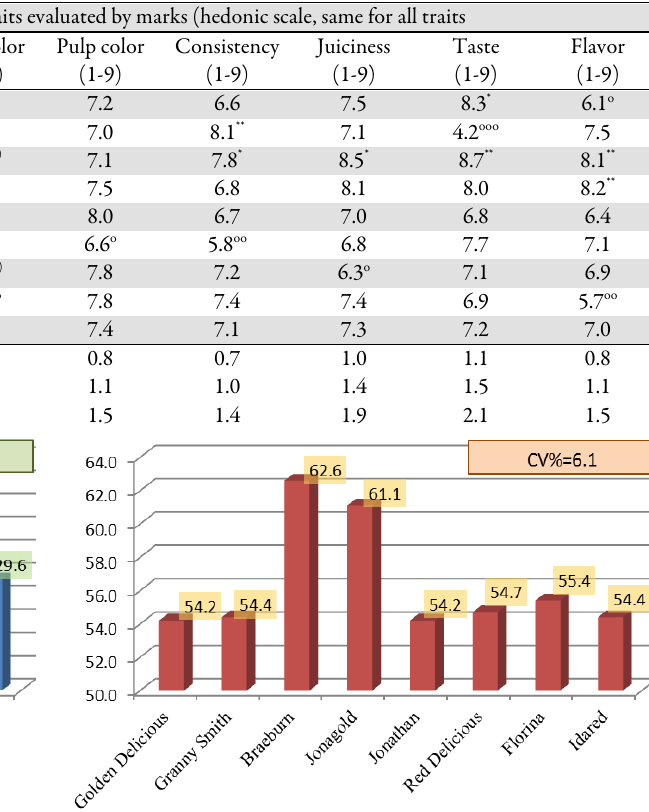
Fig. 5. Overall score for each apple cultivar based on Questionnaire 1 general marks